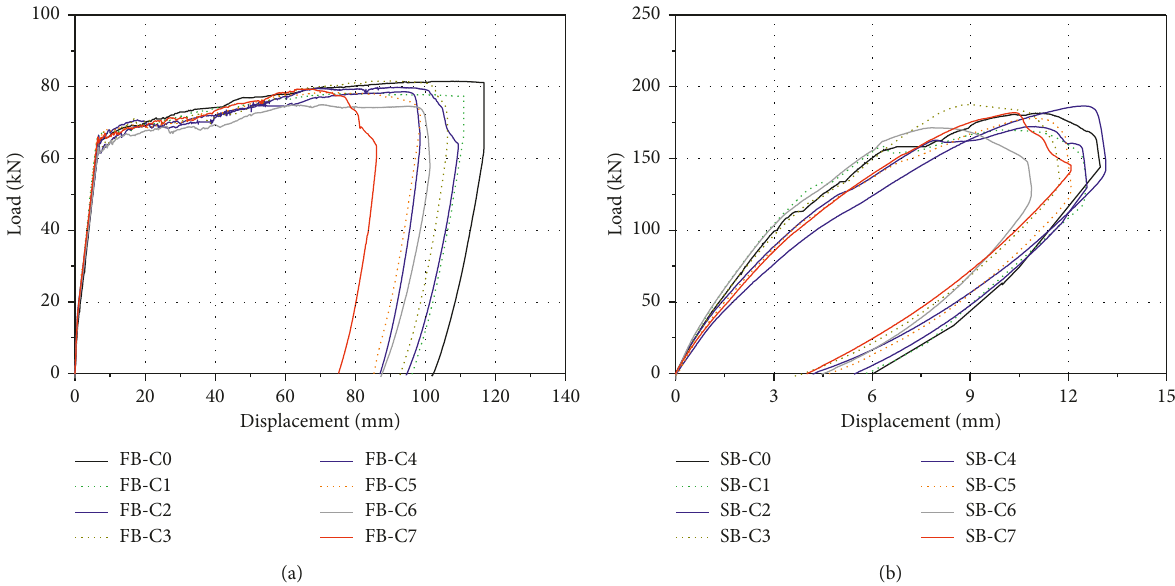
Figure 12: Load and deflection curves at the midspan of beams: (a) flexural failure type beams and (b) shear failure type beam.